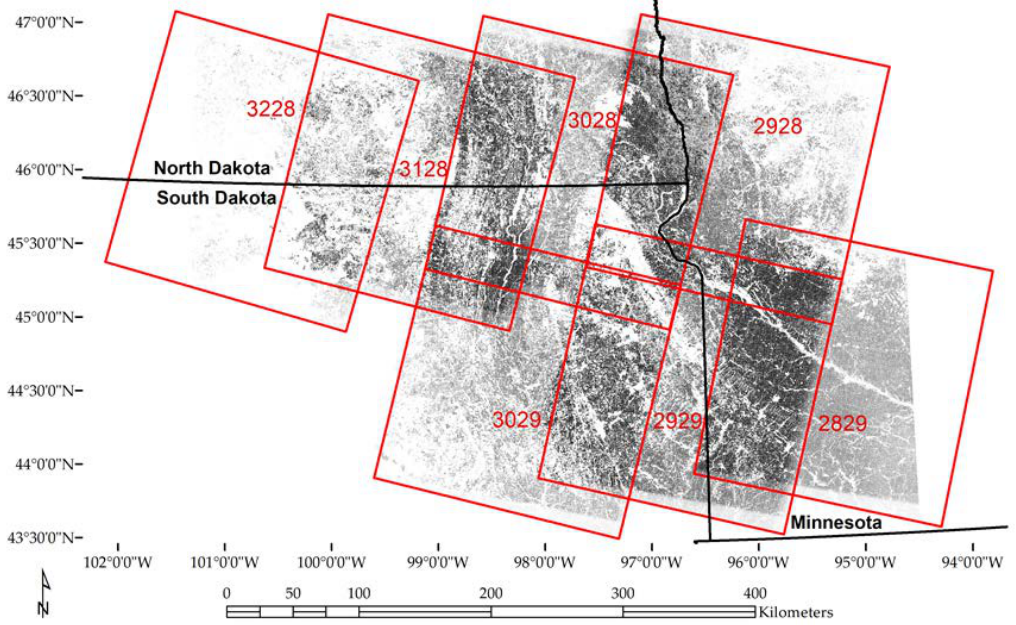
Figure 3. Locations of Landsat scene by path and row for the study area. Note east-west overlap areas. Black to white gradient indicates accumulative number of suitable images for 2007 from high counts (13) to low counts (0), respectively.